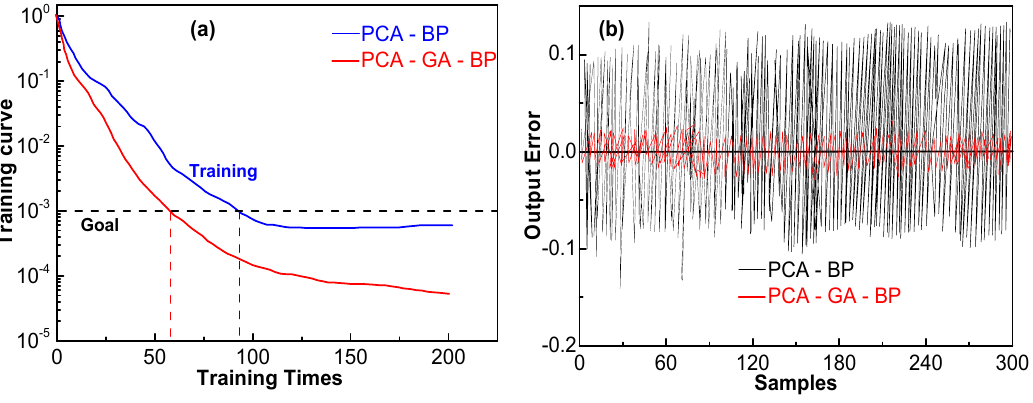
Figure 6. Training performance of PCA-BP network and PCA-GA-BP network ( a ) Training curve; ( b ) output error of the ANN network.